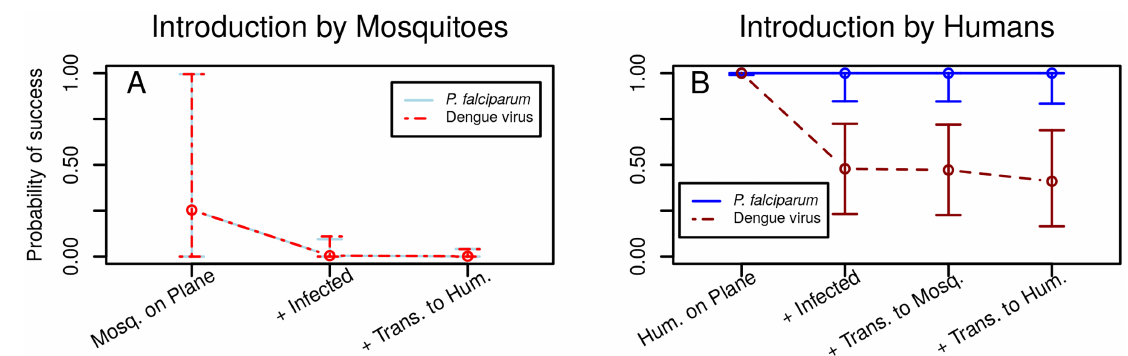
Fig 3. Step by step probabilities of success for each introduction pathway. For each sequential step in the mosquito(A) and human(B) introduction processes, we calculatedthe median(points) and 95% CredibleInterval (vertical lines)for the probabilityof at least one event occurring. For example,the median probabilitythat at least one human is on an aircraft is approximately 1.0 whilethe medianprobabilitythat there is at least one humanon an aircraft AND who is infected with a dengue virus is approximately 0.5. Note that for the introductionpathway via infected mosquitoes, the probabilities of success at each step (as well as the 95% CI) are nearlyidenticalfor both malaria and